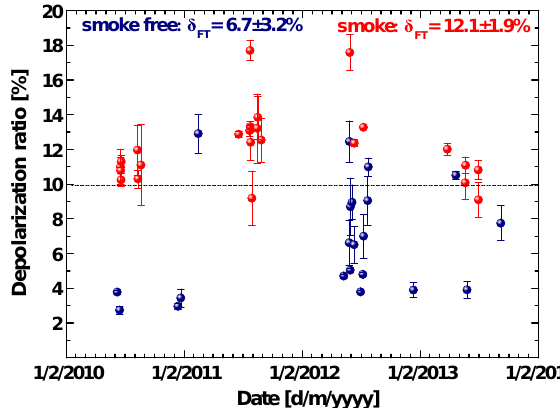
Figure 7. Layer-mean particle linear depolarization ratio of all 21 blue layers (no influence of Turkish smoke) and 24 red layers (in- fluenced by fires in Turkey) that are given in Fig. 6. Vertical bars indicate the atmospheric variability (standard deviation) of the de- polarization ratio within the detected layers. Most fire-smoke cases show enhanced particle depolarization ratios ( > 10%, red circles). The average layer-mean depolarization ratios of all 21 blue and 24 red layers and corresponding standard deviations are given as num- bers.